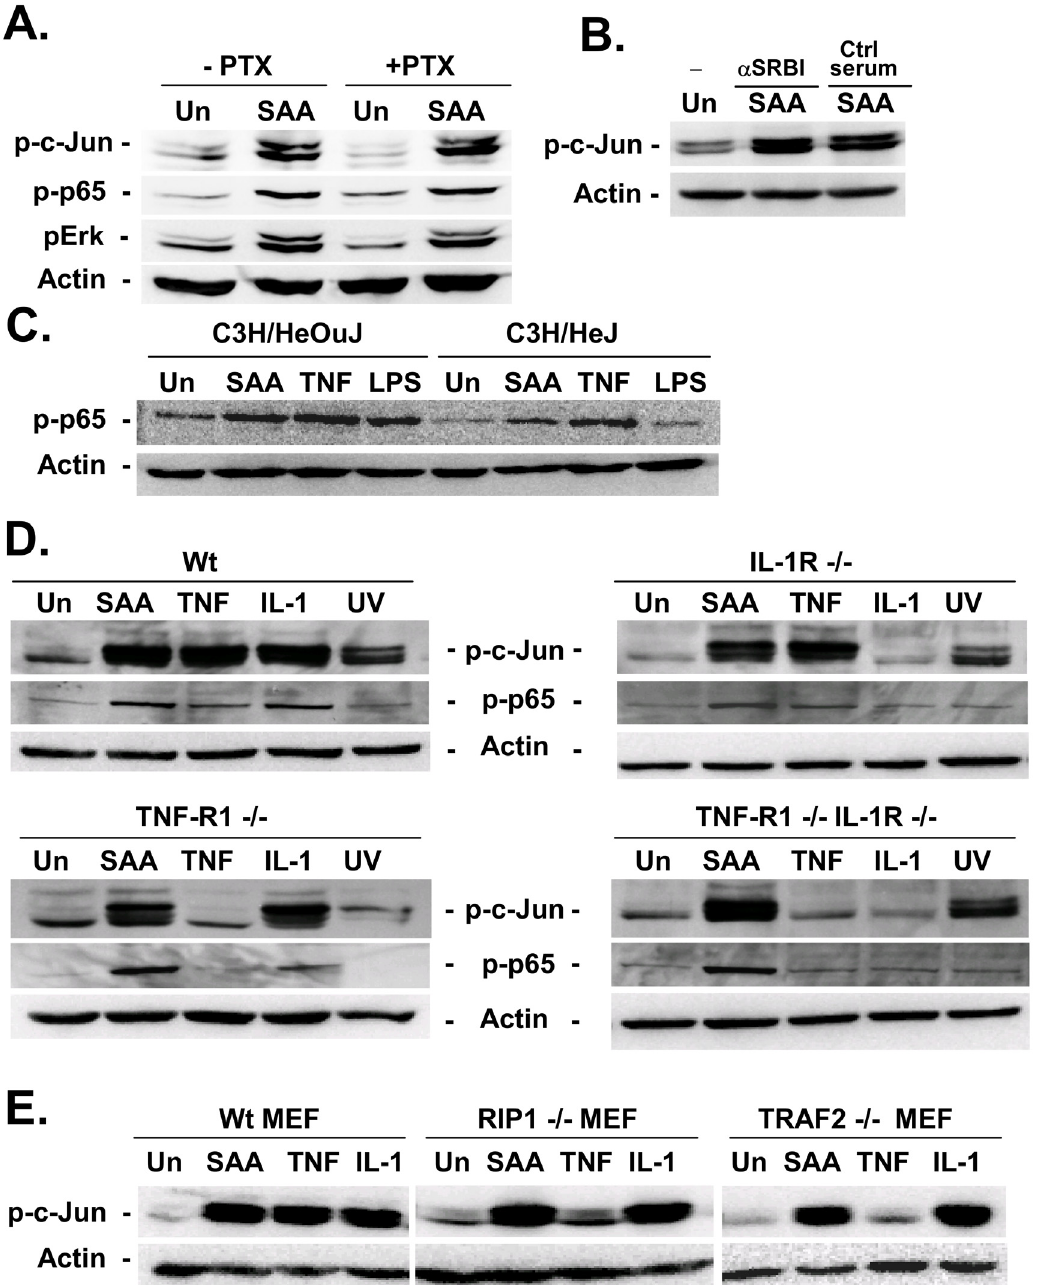
Fig 5. SAA does not signal in HSCs through TLR4, IL-1R, TNF-R1 or SR-BI. A. Activated human HSCs were pretreated with pertussis toxin followed by treatment with rhSAA (5 μ M). Activation of JNK, IKK and Erk pathways was analyzed by immunoblot for p-c-Jun, p-p65 and pErk. B. Activated human HSCs were pretreated with SR-BI blocking antibody or control antibody followed by rhSAA (5 μ M) stimulation. JNK activation was analyzed by western blot using phospho-specific antibodies for its substrate c-Jun. C. Skin fibroblasts from TLR4-sufficient C3H/HeOuJ and TRL4-deficient C3H/HeJ mice were stimulated with rhSAA (5 mM), rmTNF α (30 ng/ml) or LPS (100 nM) followed by immunoblot for p-p65. D. Skin fibroblasts from wild-type mice, TNFRI-knockout mice, IL- 1 receptor knockout mice and from TNFRI and IL-1 receptor double knockout mice were treated with rhSAA (5 μ M), rmIL-1 β (5 ng/ml), rmTNF α (30 ng/ml) or irradiated with UV (100 J/m 2 ) Activation of IKK and JNK was determined by western blot analysis for their phosphorylation of their targets p65 and c-Jun, respectively. E. Mouse embryonic fibroblasts from wild type mice, TRAF-2 deficient mice and RIP-1 deficient mice were treated rhSAA (5 μ M), rmIL-1 β (5 ng/ ml), rmTNFa (30 ng/ml) or irradiated with UV (20 J/m 2 ). Activation of IKK and JNK was determined by western blot analysis for their phosphorylation of their targets p65 and c-Jun,